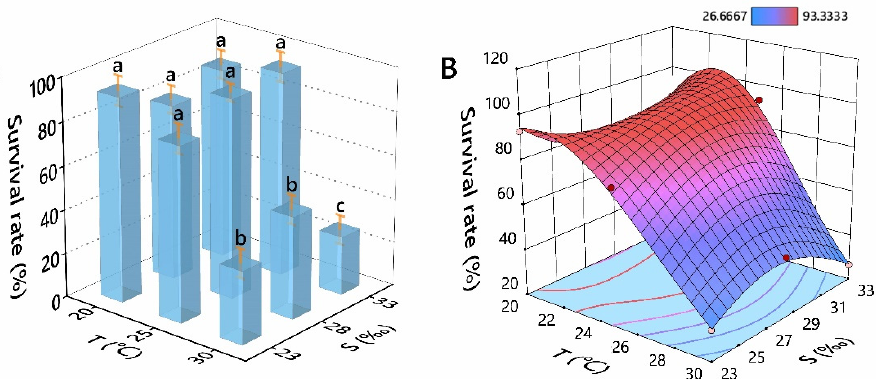
Figure 1. Effects of temperature and salinity on the survival rates of Perna viridis. (( A ) histogram; ( B ) response surface plot). Different letters indicate significant differences ( p < 0.05).